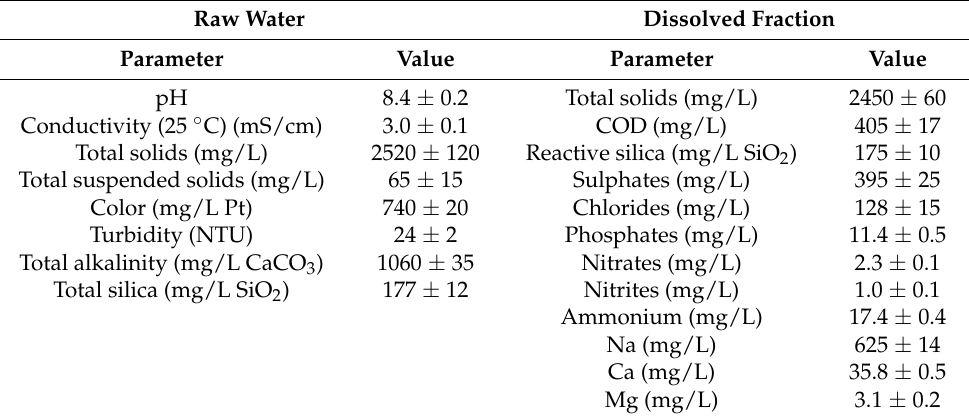
Table 1. Characteristics of the effluent (raw water and dissolved